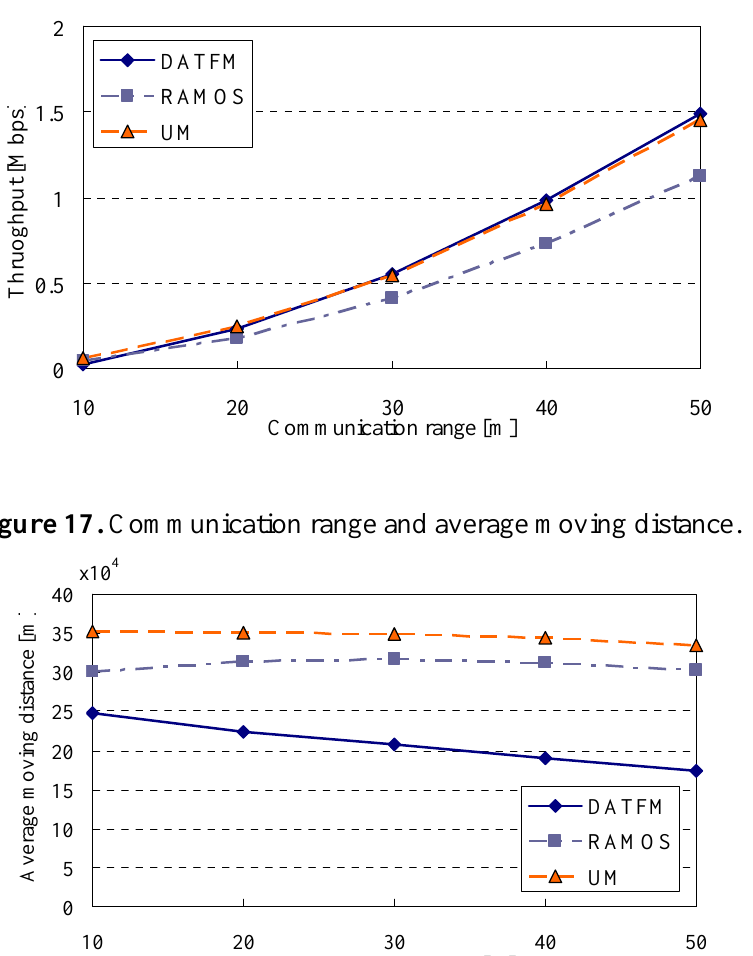
Figure 16. Communication range and throughput.